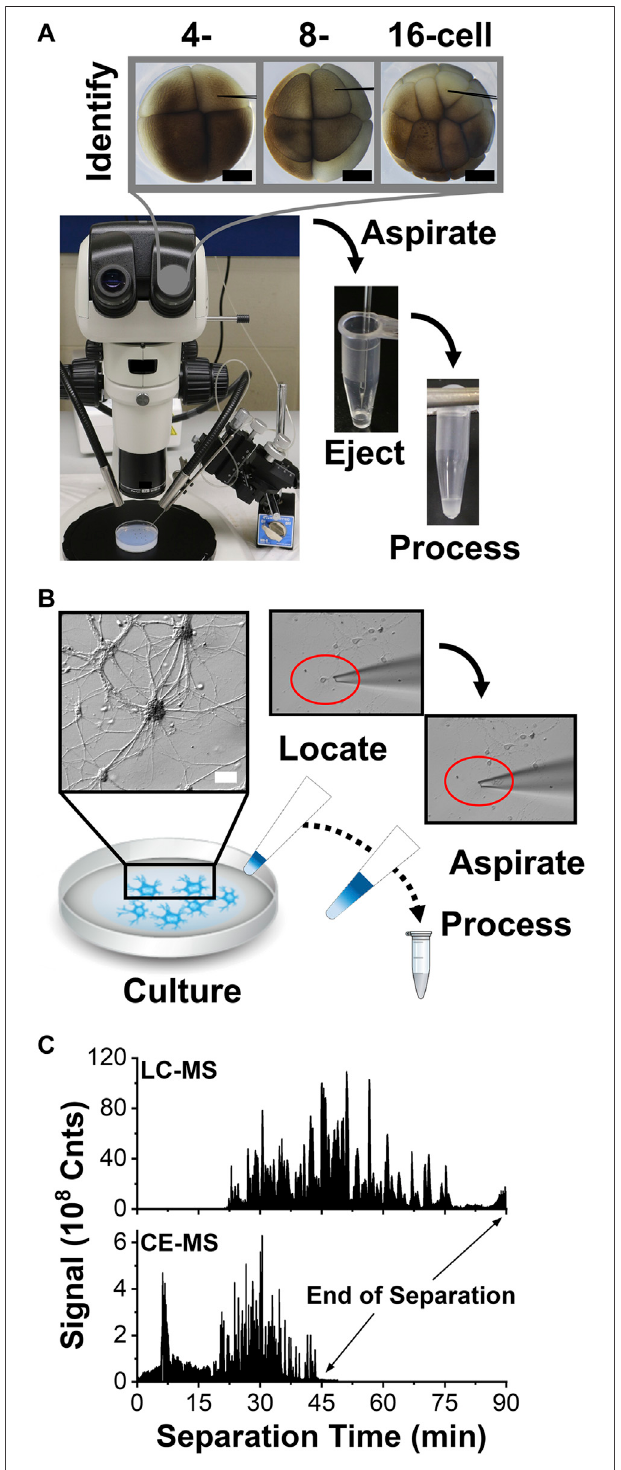
FIGURE 2 | Scale, 20 µm. (C) Representative base-peak ion signal traces recorded between m/z 350 – 1,500 from 400 ng of digest using nanoLC and 10 ng of protein digest using CE, revealing enhancement in sensitivity and speed by